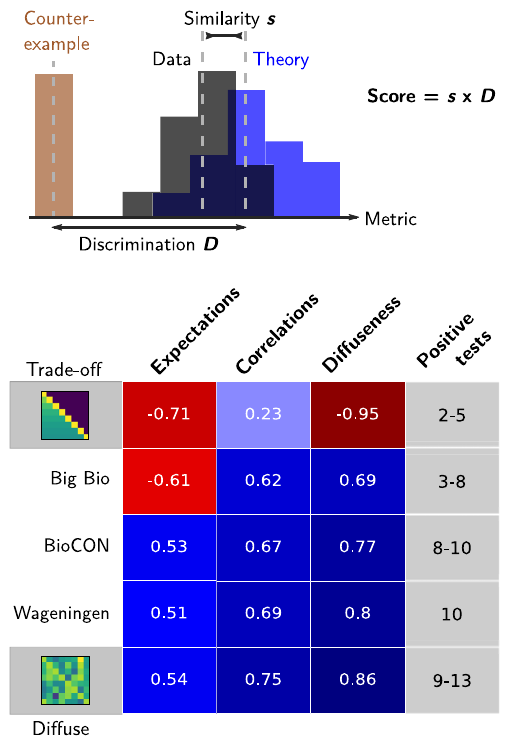
FIG. 6. Cross-experiment validation of the diffuse clique structure. Multiple quantitative tests are needed to confirm agreement between data and theoretical predictions while